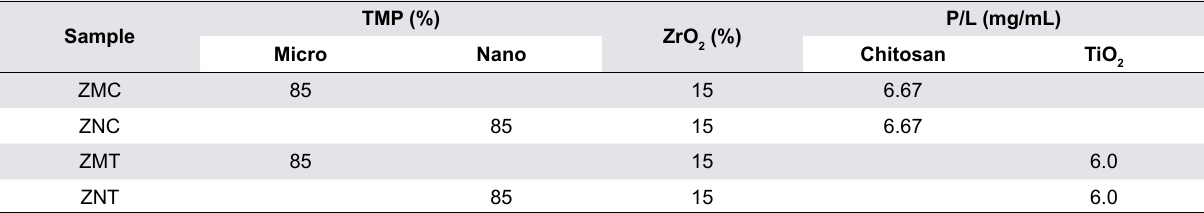
Table 1- Chemical composition of pulp-capping cements investigated in this study: ZMC, ZNC, ZMT, and